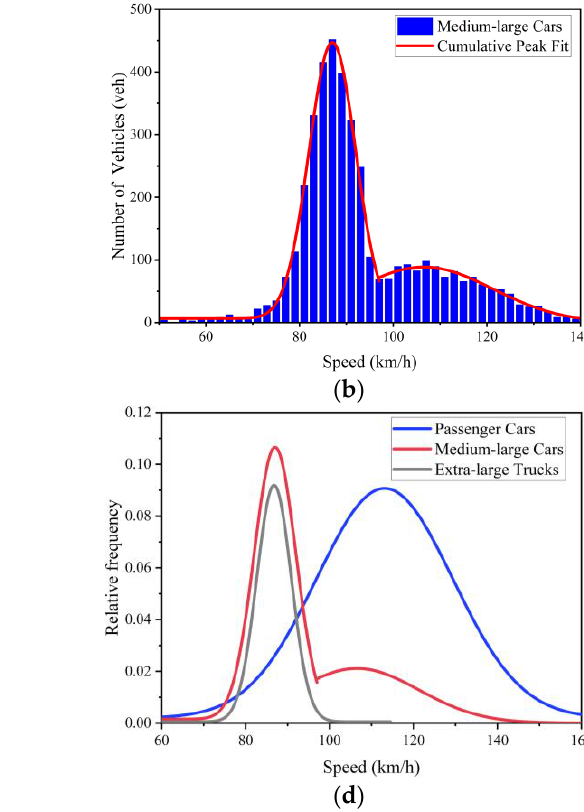
Figure 6. ( a ) Speed distribution of passenger cars; ( b ) Speed distribution of medium-large cars; ( c ) Speed distribution of extra-large trucks; ( d ) Relative frequency of speed for all types of